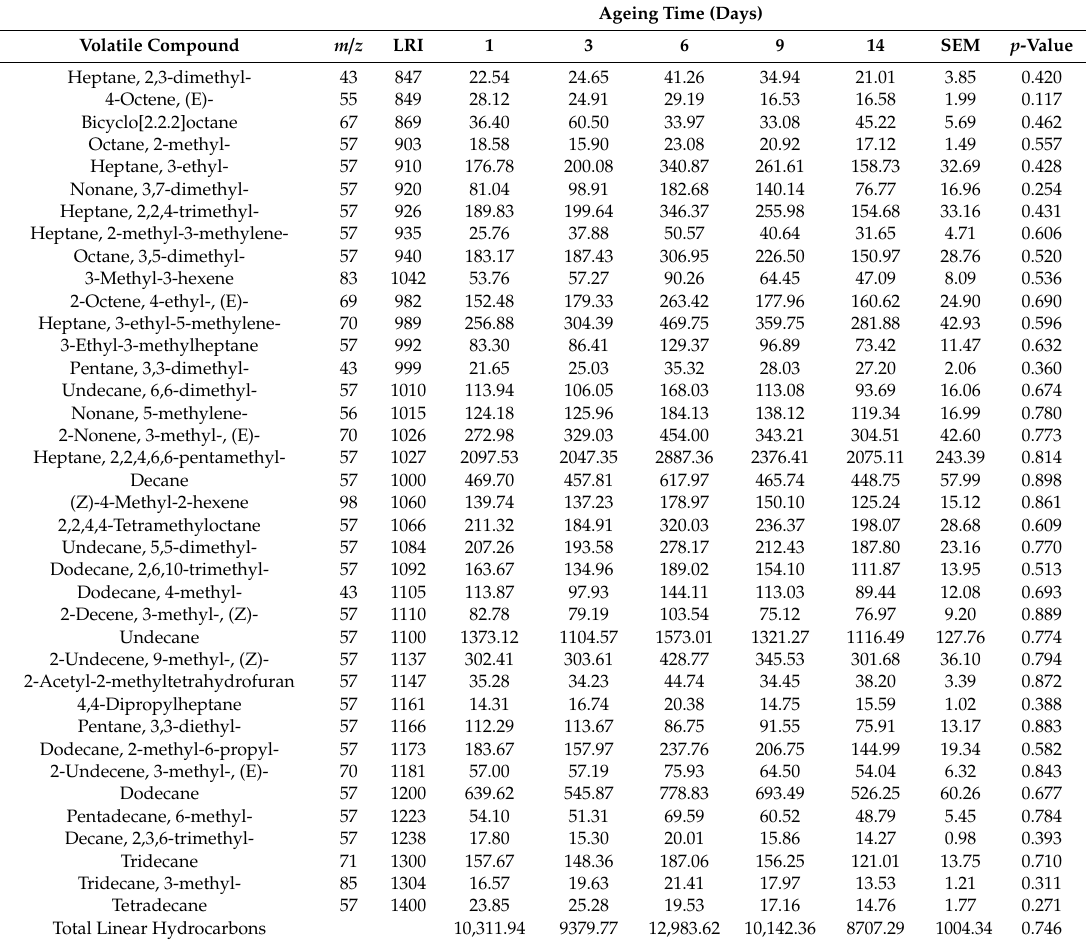
Di ff erent letters in the same line show statistical di ff erences ( a,b,c : p < 0.01). SEM: standard error of mean; m / z : Quantifier ion; LRI: Lineal Retention Index calculated for DB-624 capillary column (J&W scientific: 30 m × 0.25 mm